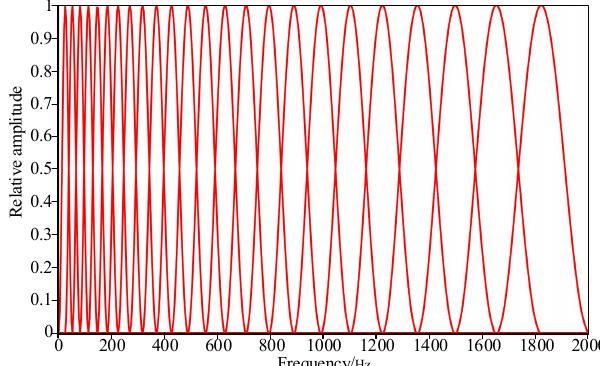
Figure 7. Transfer function of 24 Mel filters.